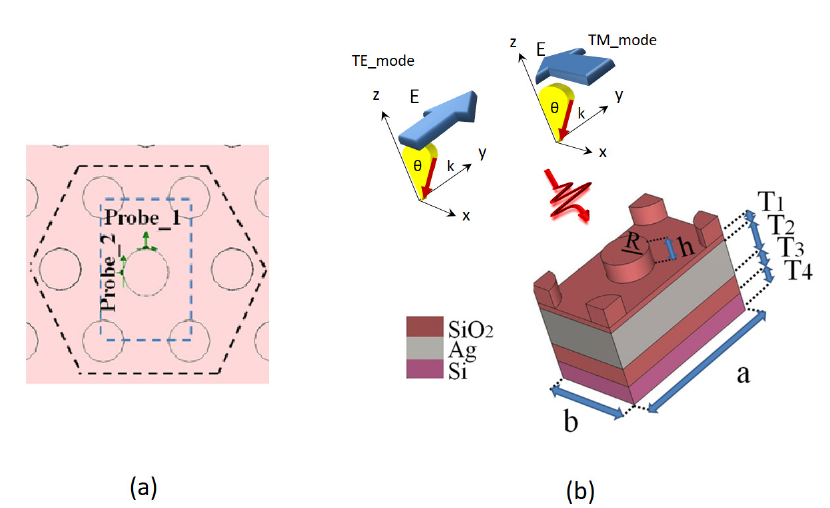
Figure 1. ( a ) Top view of the triangular lattice of the SiO 2 cylinders forming PPhC in combination with Ag film underneath. Blue dashed line represents the boundary of the unit cell. Local probes that measure the E-field are shown by green dots with arrows; ( b ) 3D model of the unit cell with the definition of the geometric dimensions and polarizations corresponding to TE and TM modes of the Floquet port.